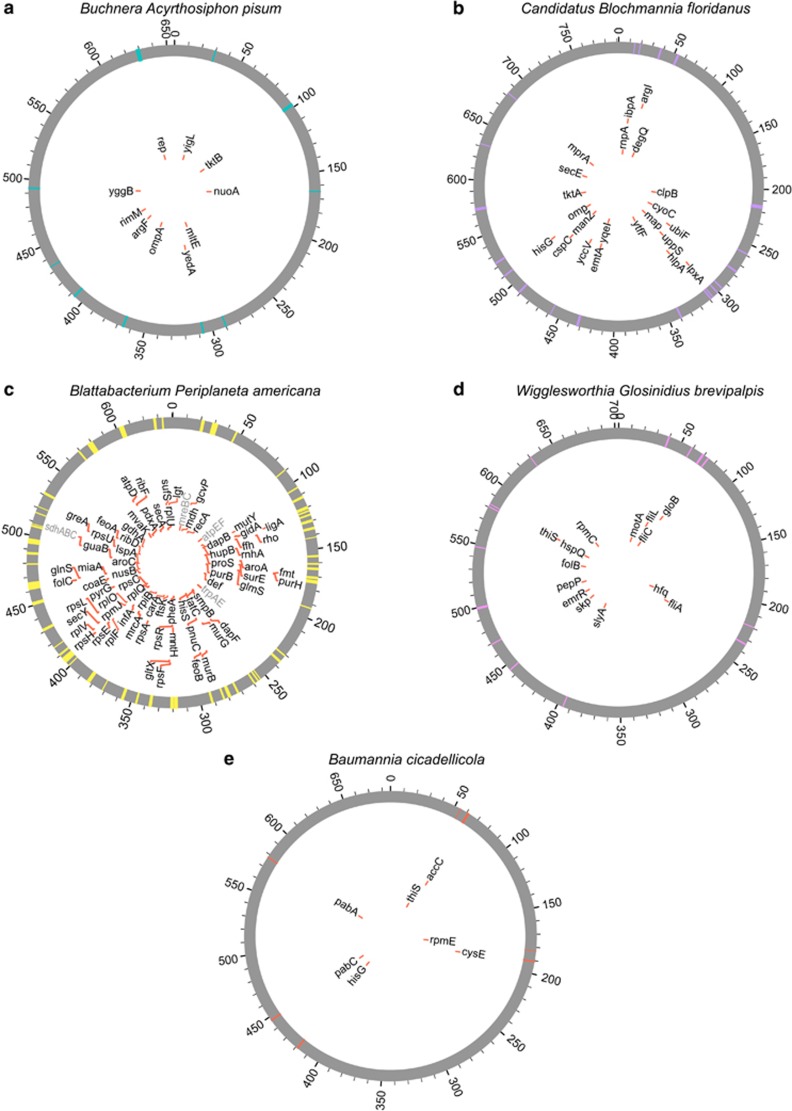
Genome distribution of genes with strong selective constraints in endosymbiotic bacteria. We identified genes with strong constraints in each of the five endosymbiotic bacterial lineages: (a) Buchera aphidicola (from Acyrthosiphon pisum); (b) Candidatus Blochmannia (Blochmannia floridanus); (c) Blattabacterium from Periplaneta americana; (d) Wigglesworthia glossinidia; and (e) Ca. Baumannia cicadellinicola. Genes indicated in the circle-representation of the endosymbiotic genomes are those that were specifically identified in that endosymbiotic genome and not the others from the same group. These genes are mostly related to the metabolism of the bacterium that interacts with the metabolism of the insect host.